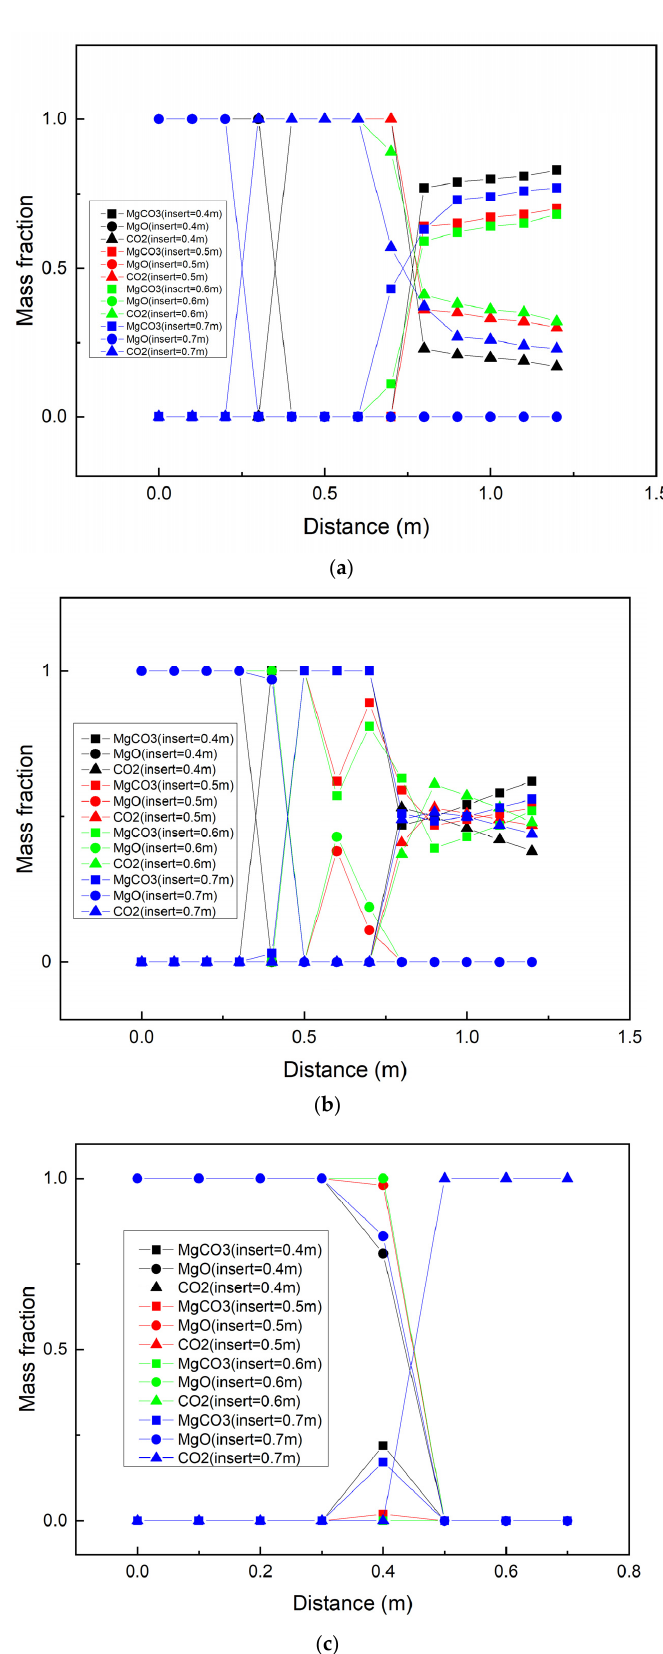
Figure 11. ( a ) Distribution of components at position Y = − 0.65 m. ( b ) Distribution of components at position Y = − 0.15 m. ( c ) Distribution of components at position Y = 0 m.